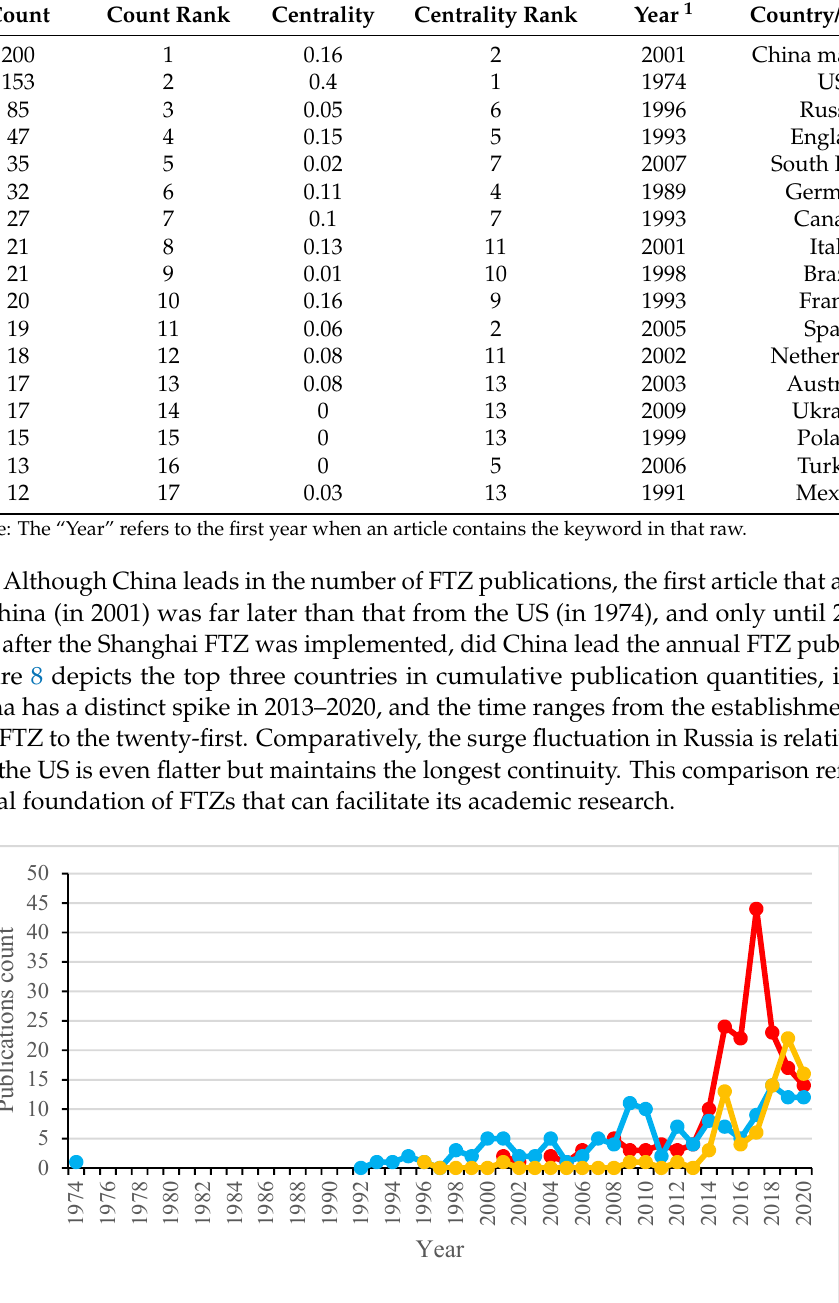
Table 2. FTZ’s count numbers of the country/region.